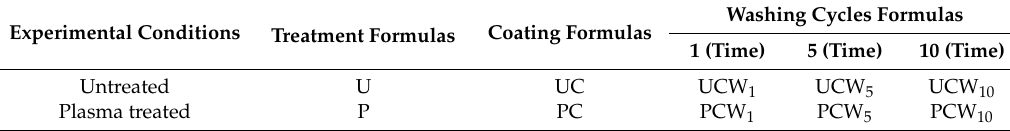
Table 1. The sample names used in the experiment .